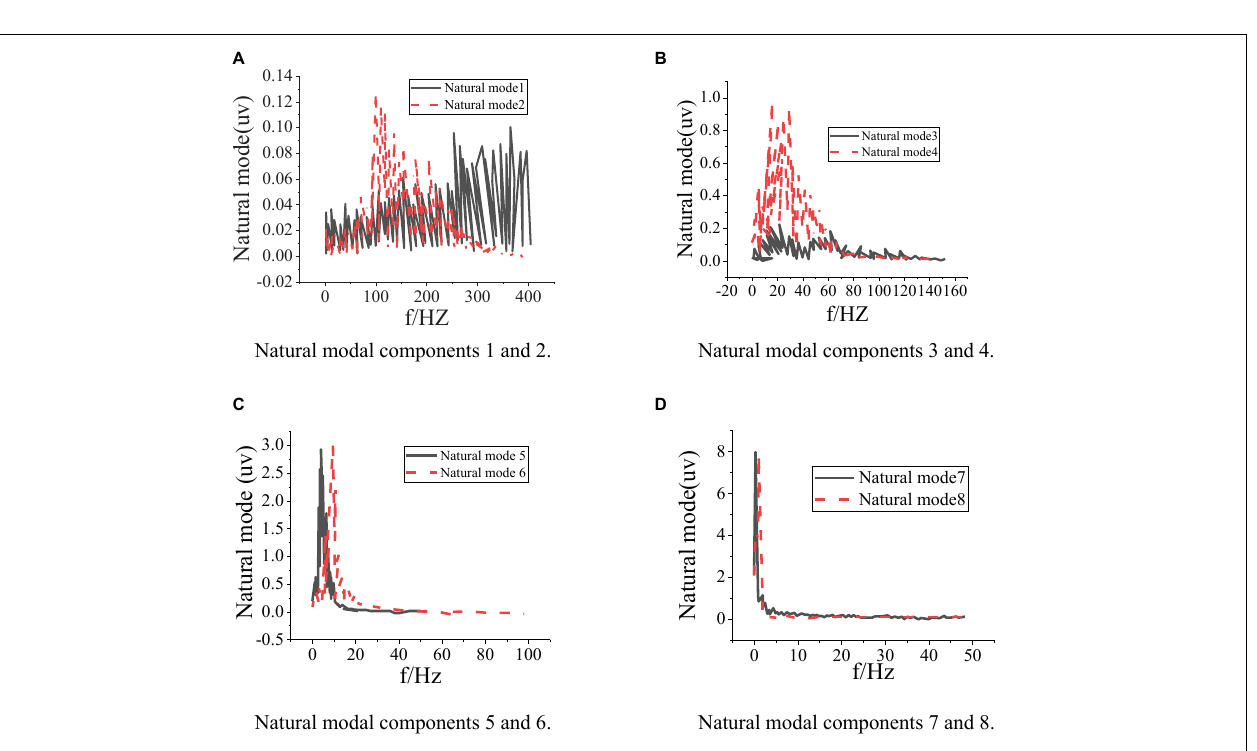
Frontiers in Psychology |